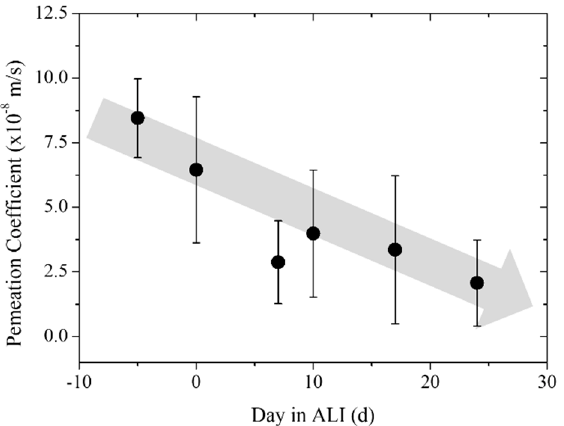
Figure 12. Permeation coefficient over the time of the ftSE. The permeation of fluorescein sodium salt through the ftSEs was observed over time. The ALI was executed at day 0. The days before pre-culture are declared with a minus. A continuous decrease of permeation over time can be seen (gray arrow). Table 2. Result of the permeation experiments with fluorescein sodium salt through the ftSE. The permeation at different times during the cultivation was investigated.